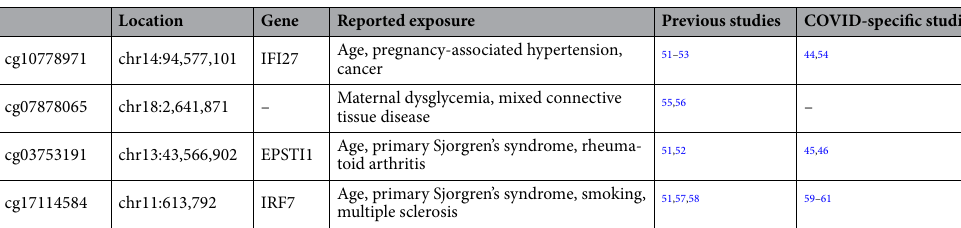
Table 3. Genome association of CpG sites. IFI27 interferon alpha inducible protein 27, EPSTI1 epithelial stromal interaction 1, IRF7 interferon regulatory factor 7.